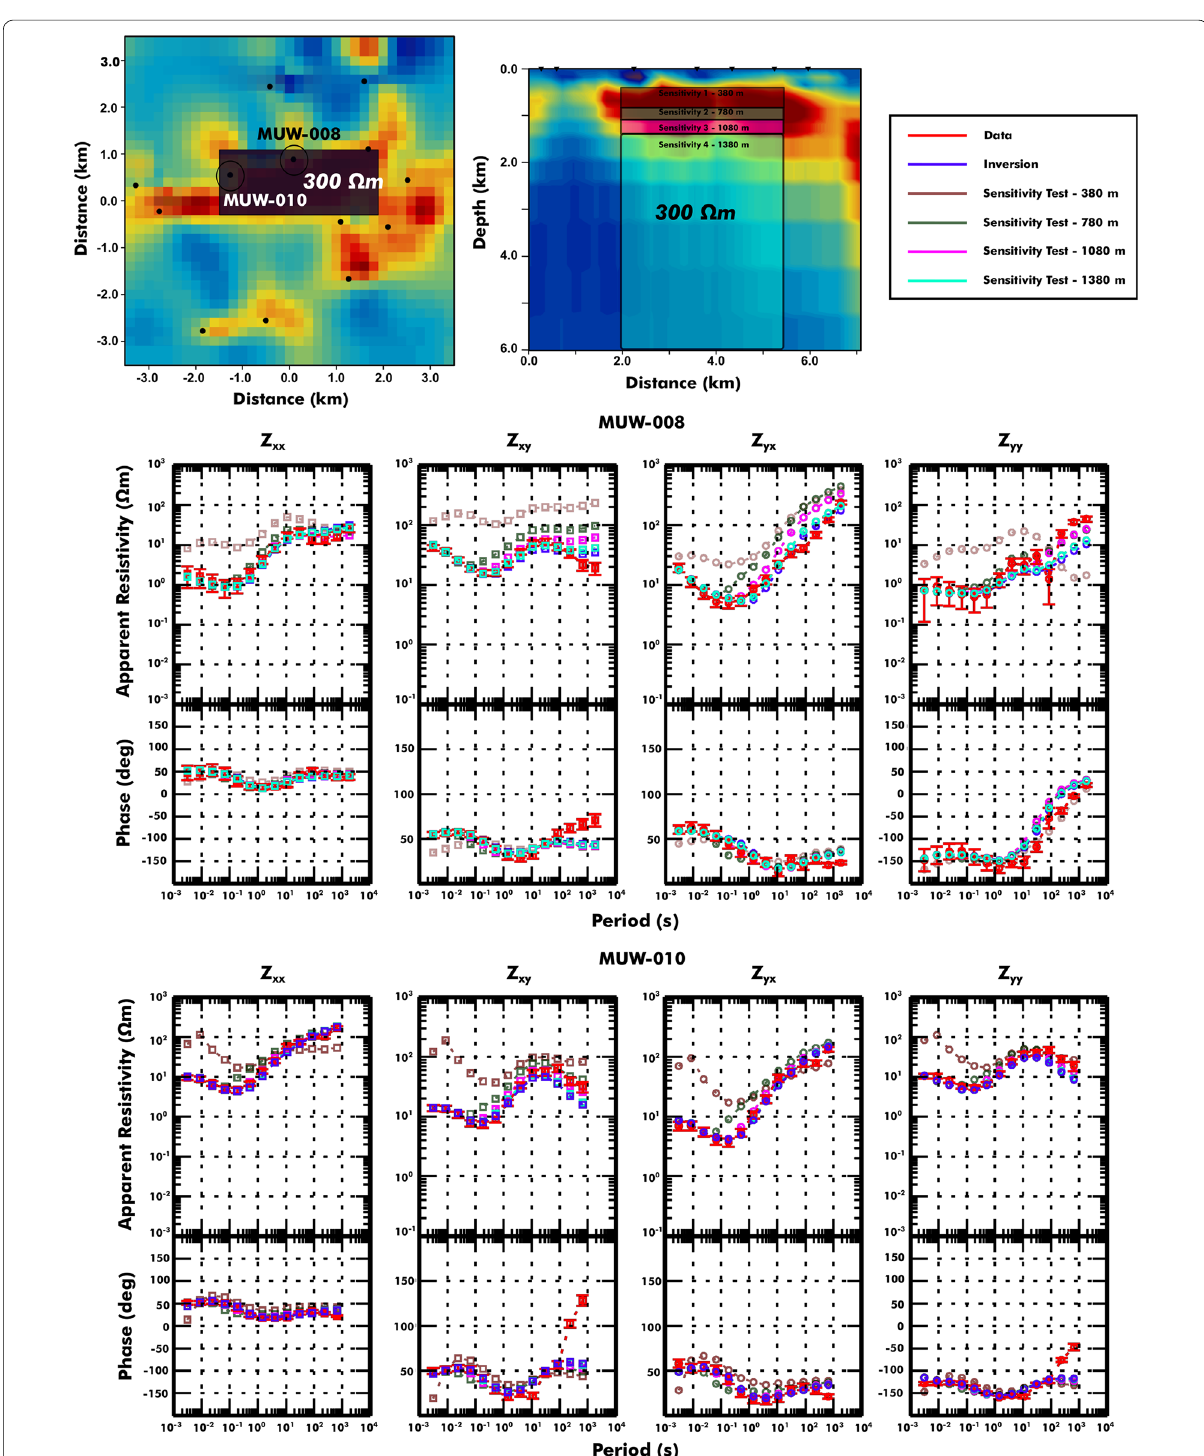
Fig. 7 Sensitivity test to determine the thickness of the fault zone conductor (FZC). A resistive block (300 Ωm) is inserted instead of the FZC at dif- ferent levels: 1380, 1080, 780, and 380 m. The forward responses were calculated and compared with final model responses. Based on the test, the depth of the FZC ranges between ~800 and 1000